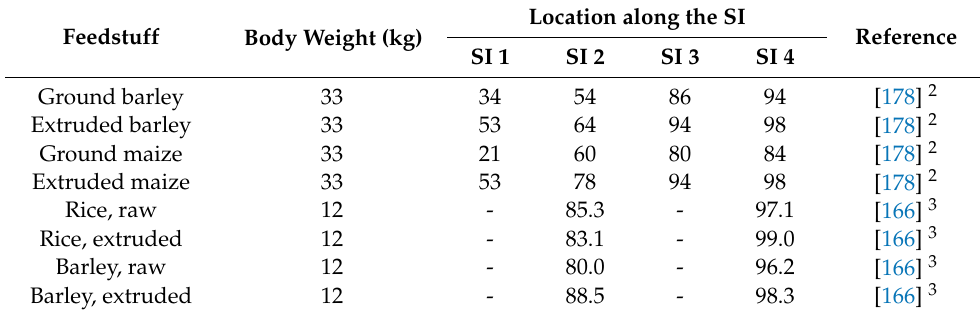
Table 4. Starch-digestibility kinetics along the small intestine 1